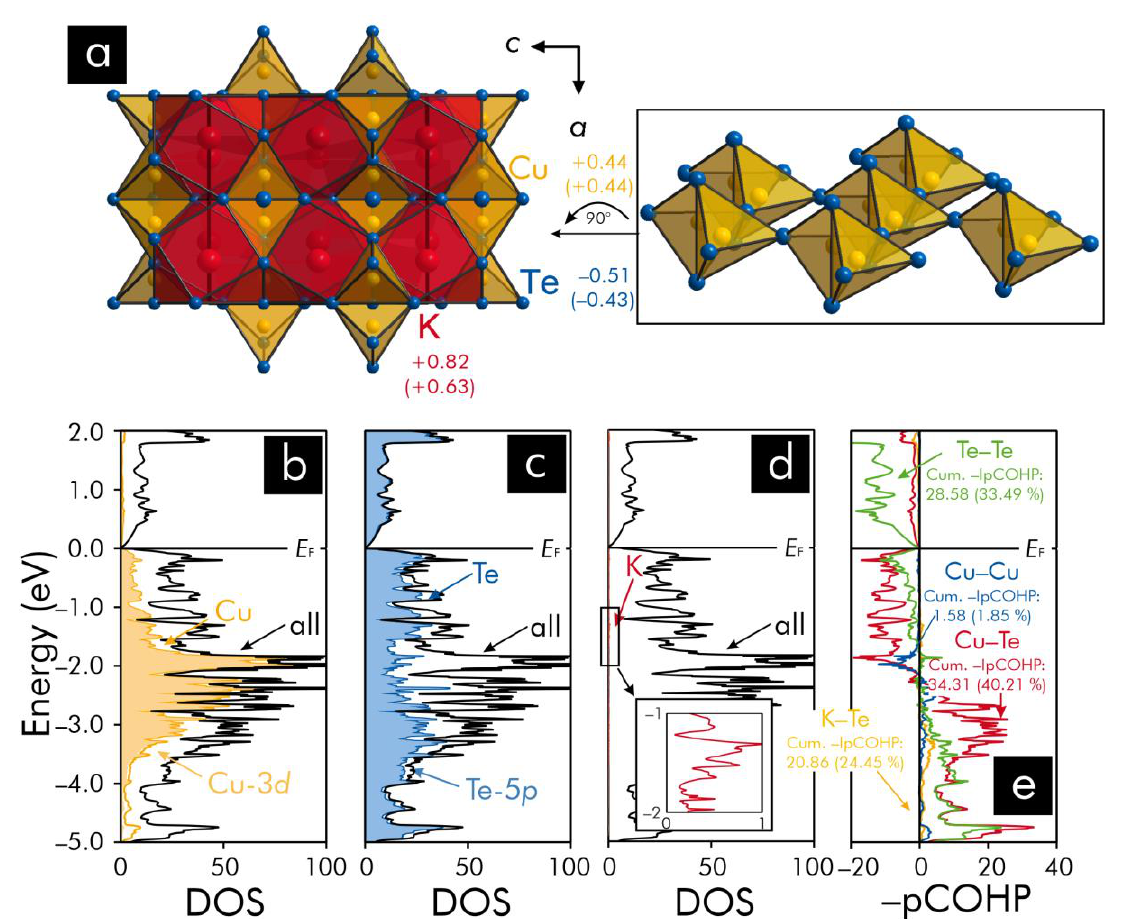
Figure 3. ( a ) Representation of the crystal structure of K 2 Cu 2 Te 5 : the tellurium polyhedra surrounding the copper and potassium atoms are shown in the insets, while the respective averaged Mulliken and Löwdin charges (in parentheses) have been included. ( b – d ) total, atom-, and orbital-projected densities-of-states (DOS) curves: the orbital-projected DOS are related to those states providing the largest contributions to the respective atom-projected DOS near the Fermi level, E F , that is represented by the black horizontal lines and ( e ) projected crystal orbital Hamilton populations (pCOHP): the respective cumulative –IpCOHP / cell values and their percentages to the net bonding capabilities have been included.